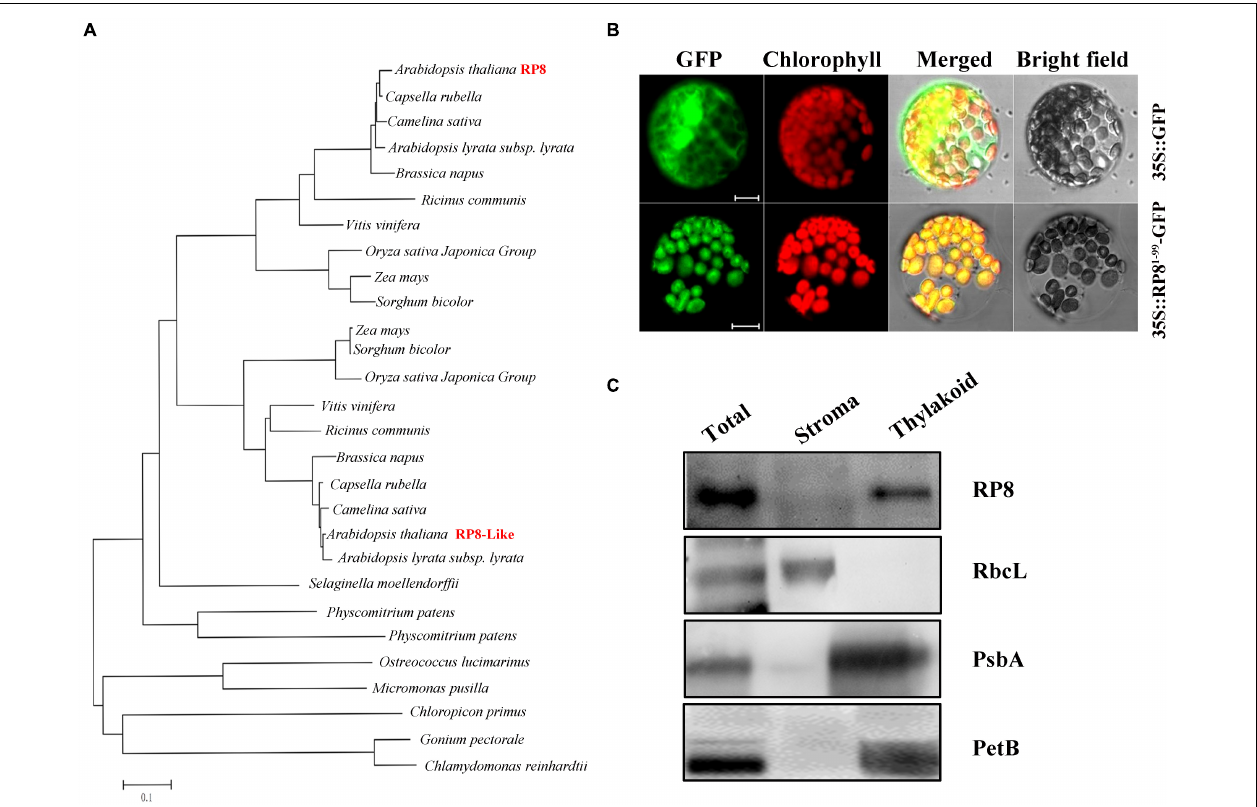
FIGURE 2 | Sequence, phylogenetic analysis, expression pattern, and subcellular localization of the RP8 protein. (A) Phylogenetic analysis of the RP8 protein and its homologs. Maximum likelihood analysis of the RP8 protein and its homologs from various organisms was performed. The unrooted phylogenetic tree was constructed by the Neighbor-Joining method (Saitou, 1987) with genetic distance calculated by MEGA 3.1. (B) Subcellular localization of RP8. Transit peptide of 99 amino acid residues at the N-terminus of the RP8 protein fused with GFP was transformed into N. benthamiana protoplasts by PEG transformation. The red-colored chlorophyll autofluorescence and GFP fluorescence were detected by a laser confocal-scanning microscopy after infiltration. Bars = 5 µ m. (C) Immunoblot analysis of RP8 in chloroplast subfractions. Stromal and thylakoid proteins fractions were prepared and separated by SDS-PAGE. Immunoblot analysis using antibodies against RbcL, RP8, PsbA, and PetB was performed. Each lane was loaded with 30 µ g